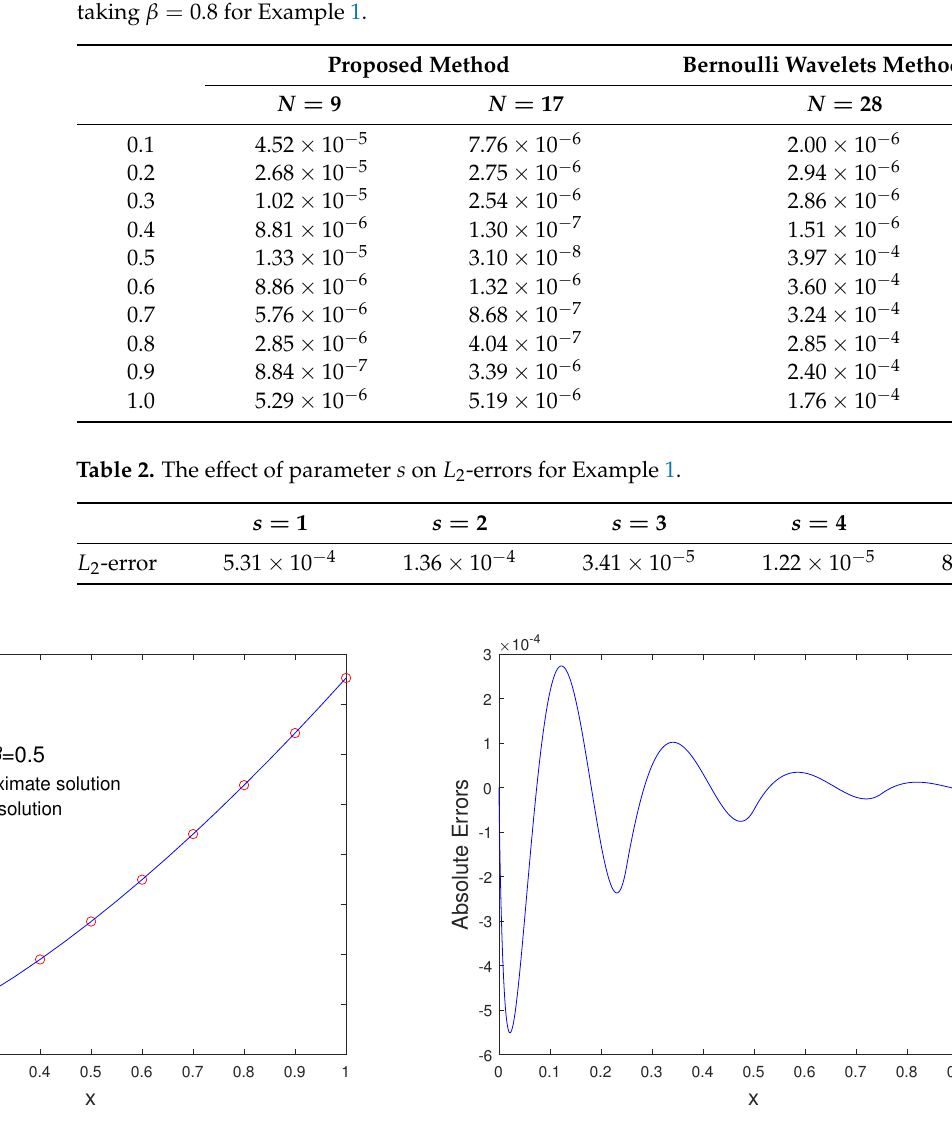
Figure 1. Comparing the approximate and exact solutions, taking s = 2 and β = 0.5, for Example